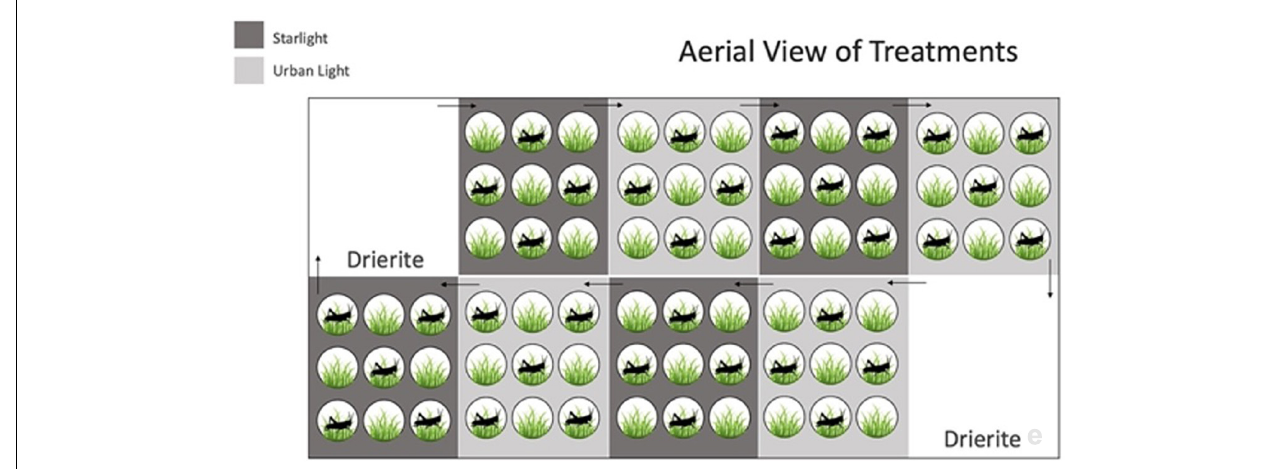
FIGURE 1 | Aerial view of treatment groups in the growth chamber after crickets were introduced (day 21–28). The treatment groups were arranged in a block test pattern with 4 blocks of urban light treatments and 4 blocks of starlight treatments, totaling 8 groups. Within each block, nine plants (every other one) had a cricket.